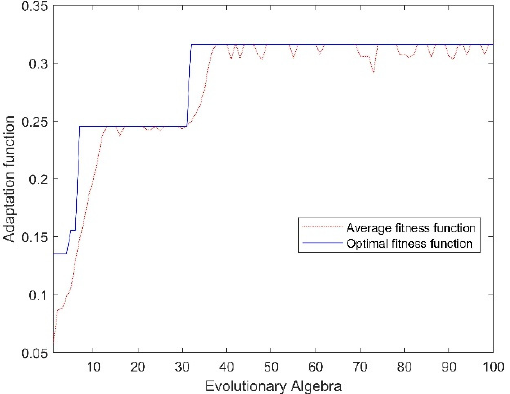
Figure 9. Evolutionary plot of optimal fitness function.